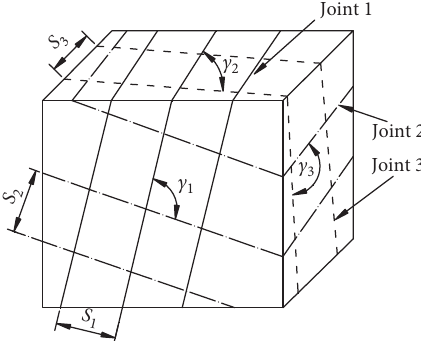
Figure 5: Sketch map of rock mass delimited by three joint